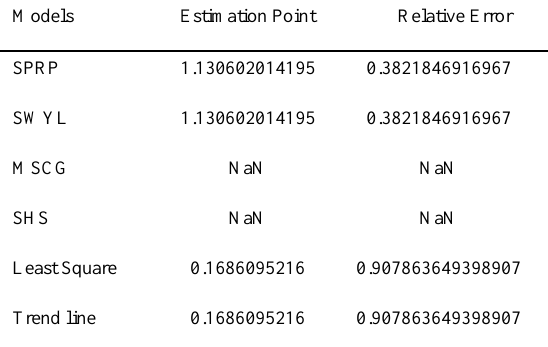
Table 7. Estimation Point and Relative Errors for 2017 Data